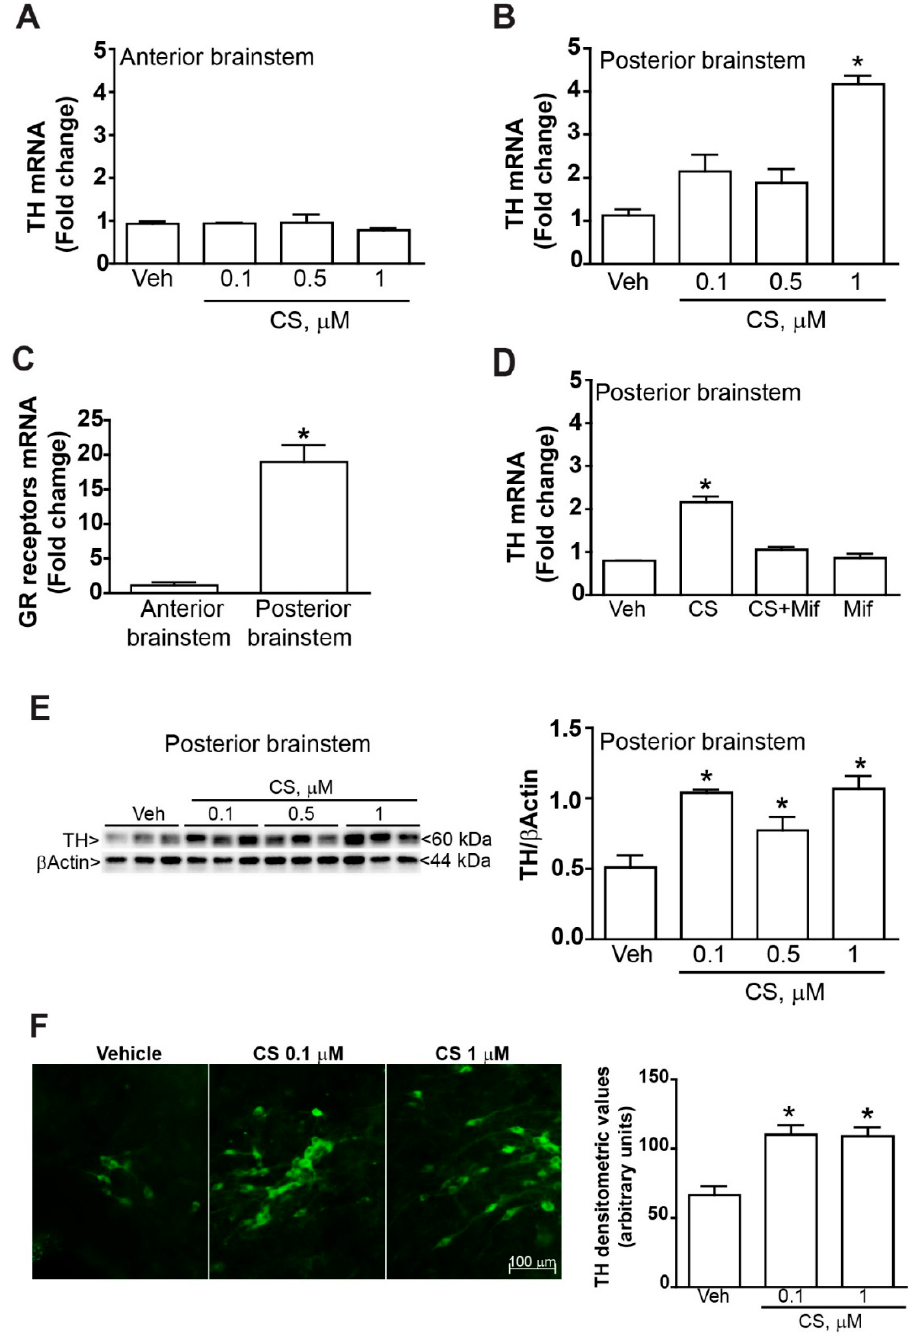
Figure 2. Corticosterone increases TH expression in the mouse brainstem. ( A , B ) Real time PCR analysis of TH mRNA in cultures from the rostral or caudal part from the mouse brainstem at 24 h vehicle (Veh, ethanol 0.01%) or CS (0.1, 0.5 or 1 µ M in ethanol 0.01%) incubation. ( C ) Real time PCR analysis of glucocorticoid receptors (GR) mRNA. ( D ) Real time PCR analysis of TH mRNA in cultures of the caudal part at 24 h incubation with either vehicle (Veh, ethanol 0.01%) or CS (0.1 µ M in ethanol 0.01%) in the presence or absence of the selective GR receptors antagonist mifepristone (Mif, 10 µ M). ( E ) Western blot analysis of TH in organotypic cultures of the caudal part of the brainstem at 24 h incubation with either vehicle (Veh, ethanol 0.01%) or CS (0.1, 0.5 or 1 µ M). ( F ) Immunofluorescence of TH in the A1 / C1 catecholamine area of the caudal part of the brainstem at 24 h incubation with either vehicle (Veh, ethanol 0.01%) or CS (0.1, or 1 µ M). Densitometry of immunofluorescence was expressed in arbitrary units. All values are expressed as the means ± SEM. * p < 0.05 compared with vehicle.